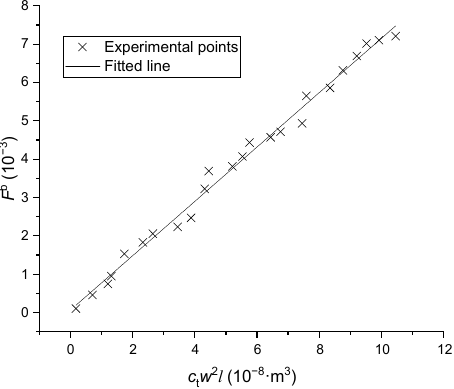
Figure 9. The breakage frequency versus particle volume.